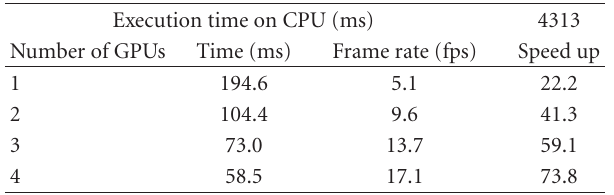
Figure 9: Nearest neighbor interpolation (a), bicubic interpolation (b), and super-resolved all-in-focus image (c). Table 1: Frame rate and speedup over sequential implementation for up to 4 GPUs.